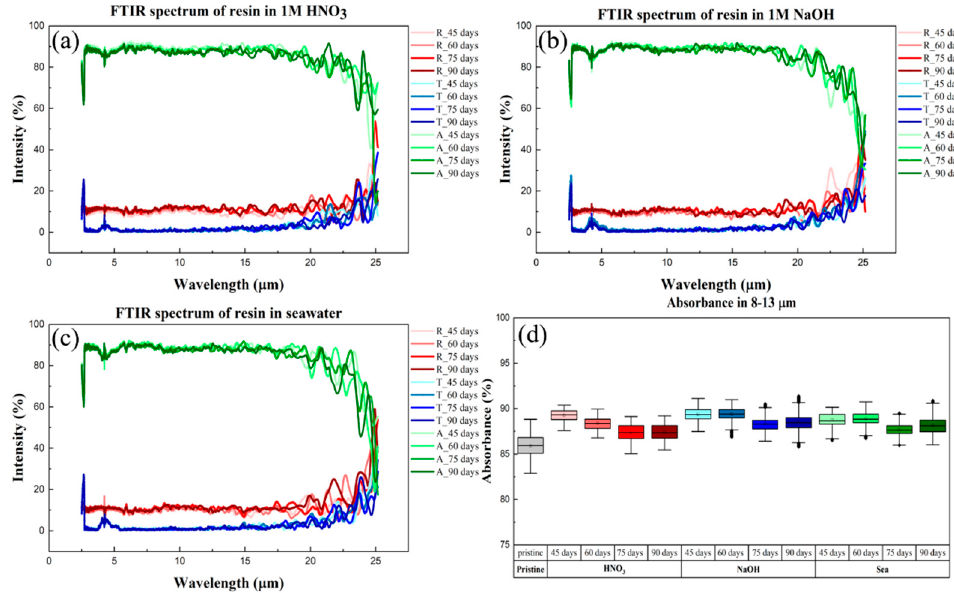
Figure 8. FTIR spectra of printed materials in ( a ) 1 M nitric acid aqueous solution, ( b ) 1 M sodium hydroxide aqueous solution, and ( c ) sea water (3.5% salt solution). ( d ) Absorbance data determined after exposure to different extreme environments for three months.